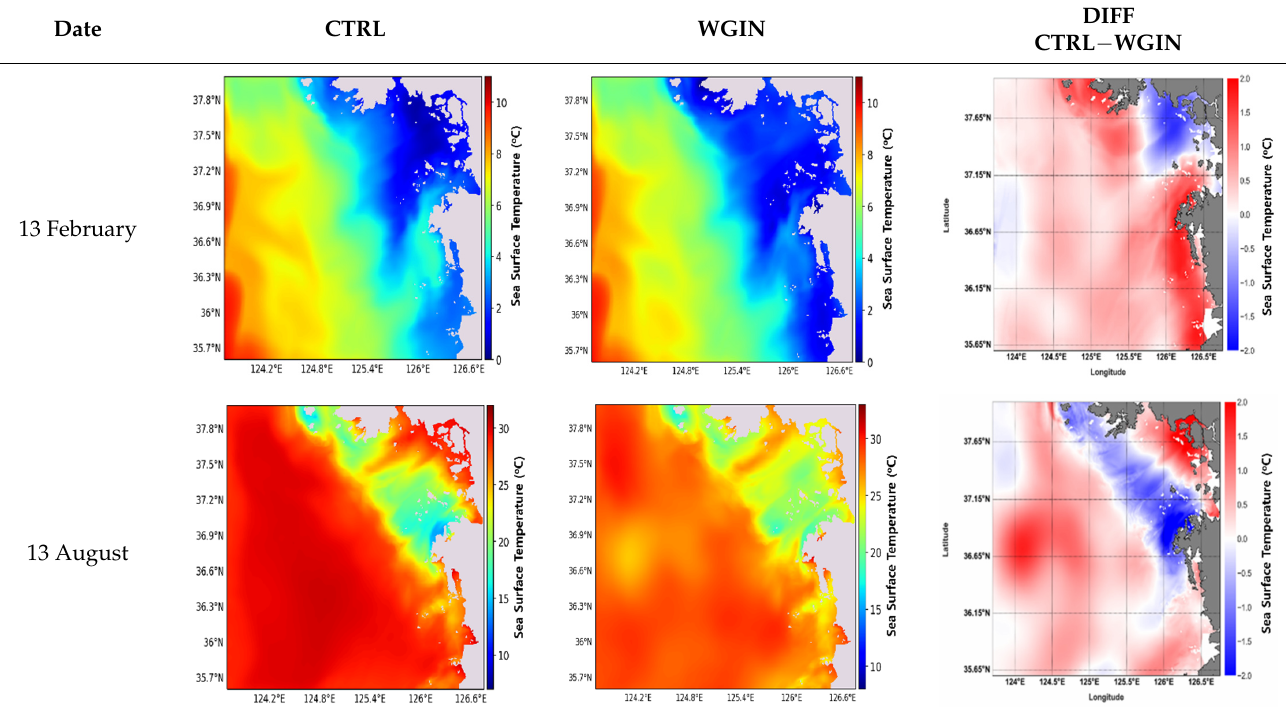
Table 3. Comparison of surface temperature distribution of the WGIN and CTRL.